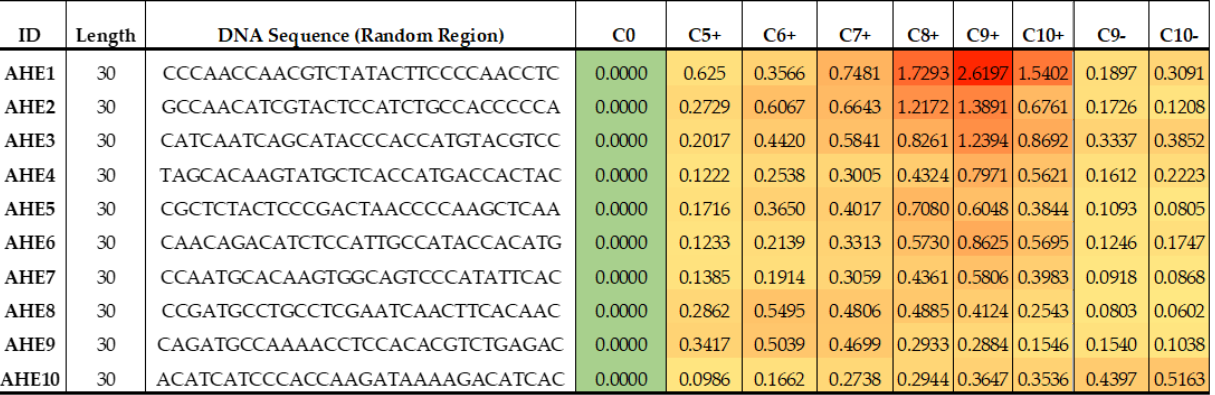
Figure 4. Evolution of the top 10 most enriched DNA aptamers targeting ovarian cancer biomarker HE4 obtained with DNA sequencing. The results show clear enrichment of certain families (especially AHE1, AHE2 and AHE3) after positive selection to target HE4 protein in urine (from cycles C5+ to C10+), but not in counter-selection (C9 − and C10 − ). C0 represents native library, C5+ to C10+ represent positive selection to target protein 6xhistidine-HE4 protein and C9 − and C10 − represent counter-selection to 6xhistidine peptide and beads (sample matrix). Green color = no enrichment to HE4, yellow = intermediate enrichment, orange = mild enrichment, red = intense enrichment to HE4